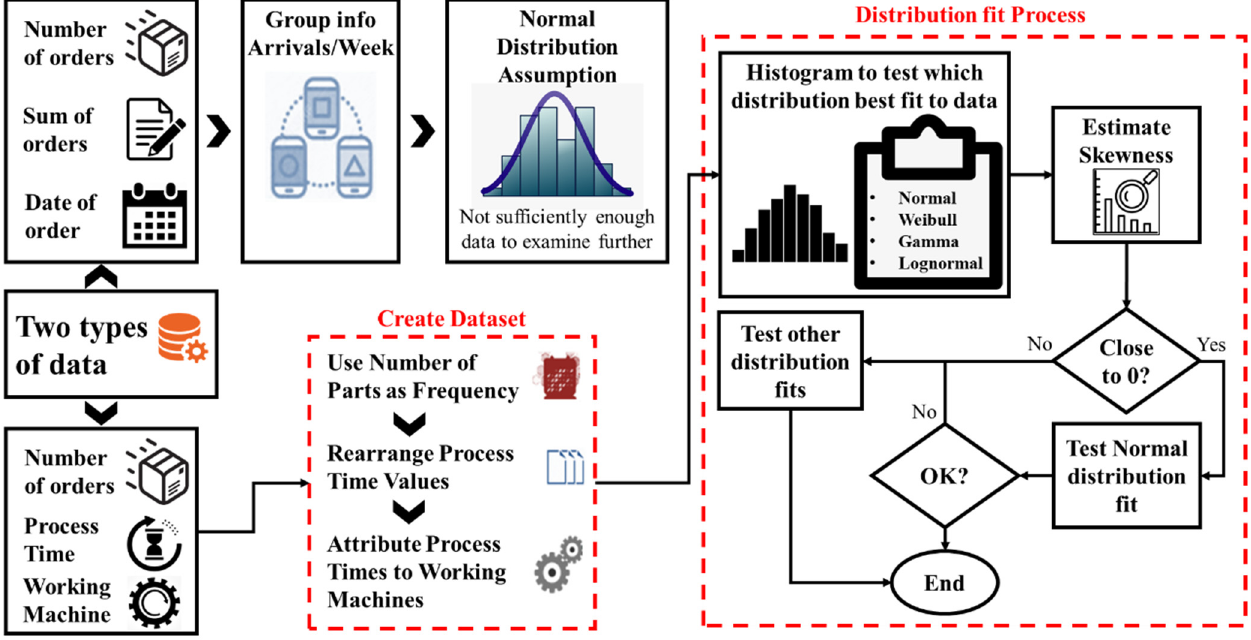
Figure 4. Flowchart for the data analysis process.